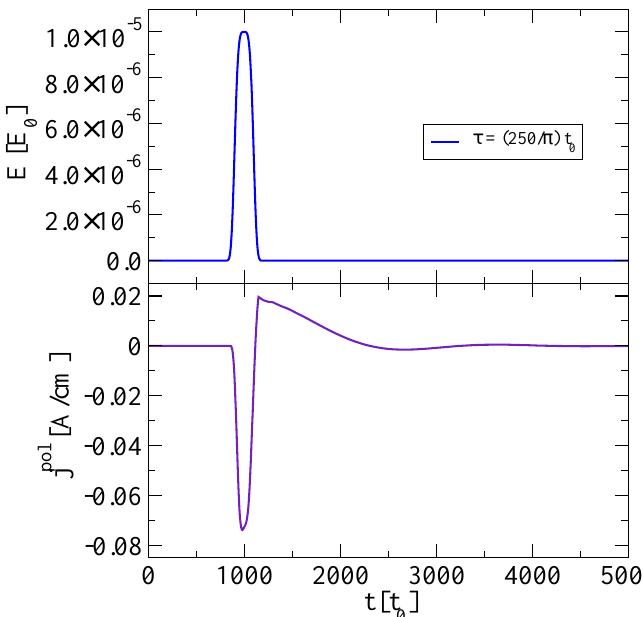
Figure 1. Upper panel: Supergaussian electric field (56) where t max = 1000 t 0 ( 2.46 × 10 − 13 s) and E a = 0.00001 E 0 ( 1.088 × 10 3 V/cm). Lower panel : The density of the polarization